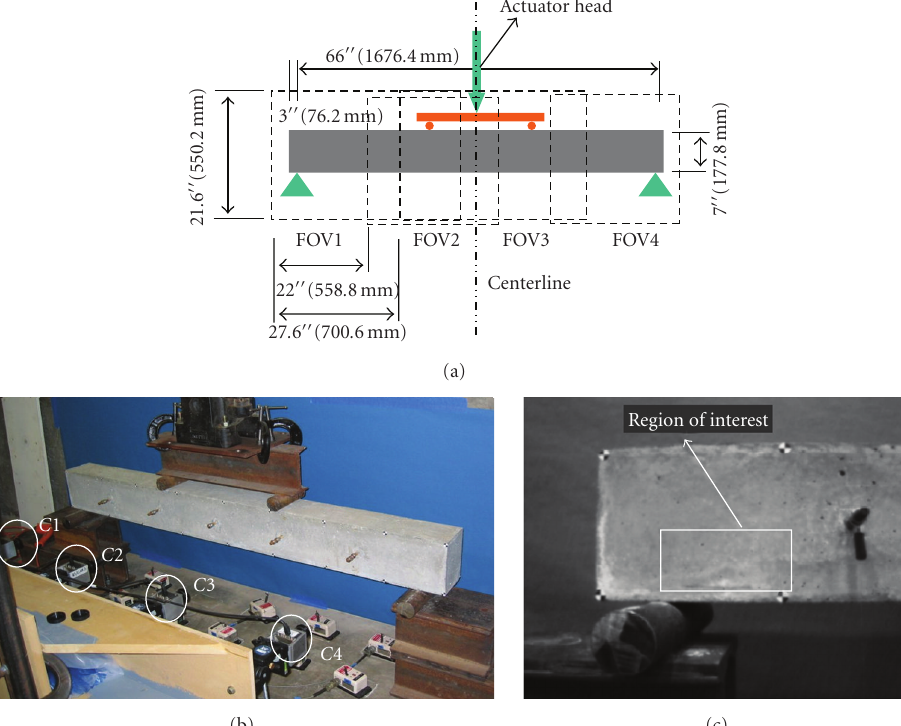
Figure 9: (a) Schematic of test set-up for a simple supported beam captured by four cameras (C1–C4 as seen in (b)); the fields of views (FOV1–FOV4) of the four cameras are overlapped and symmetric with the centerline; (b) the four cameras (C1–C4) in the real set-up; (c) the captured scene before loading by the camera C1 and the region of